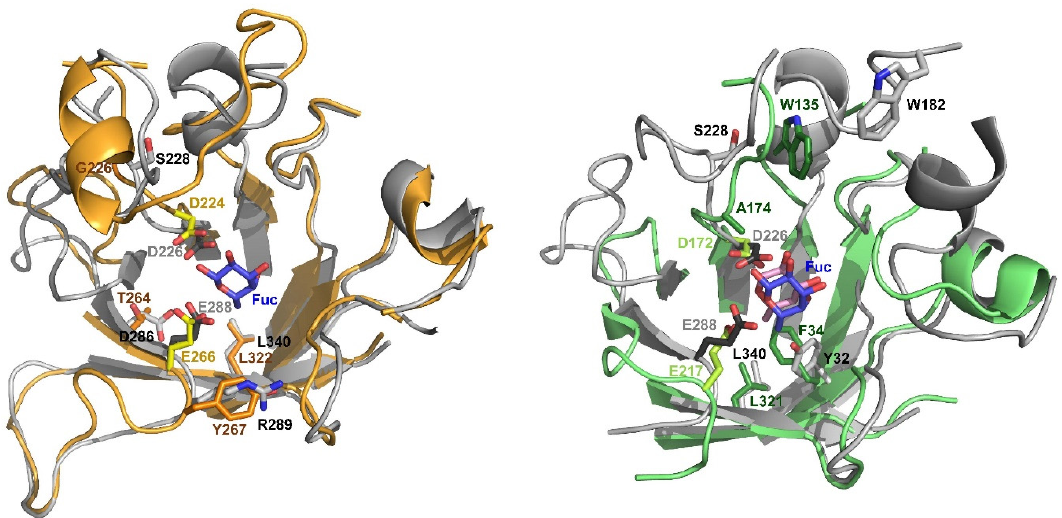
Figure 1. Active site structural alignments of Fg FCO1 (grey; PDB 4NI3) with Tm α Fuc (orange; model on PDBs 1HL9 and 2ZWY) and Bi AfcB (green; PDB 3UES) indicating catalytic residues (dark grey with grey labels in Fg FCO1, yellow in Tm α Fuc, and lime green in Bi AfcB). Residues that upon mutation had the most beneficial effect on transglycosylation in Tm α Fuc [13] and Bi AfcB [6,34] are indicated in orange ( Tm α Fuc; brown labels) or green ( Bi AfcB; green labels) alongside the corresponding residues if Fg FCO1 (grey with black labels). Corresponding Fg FCO1 residues were determined from multiple sequence alignment (Figure S1) guided by structural alignment around the catalytic acid/base (E288 in Fg FCO1), where sequence alignment is generally poor in GH29 [36]. Fuc ligands from Fg FCO1 (blue; PDB 4PSR) and Bi AfcB (pink; PDB 3UET) are indicated. Residues more than 14 Å away from the ligand are hidden for simplicity (with a few manual modifications). In the alignment of Fg FCO1 and Tm α Fuc (left) amino acids 45-76 ( Tm α Fuc) and 46-52 ( Fg FCO1) are also hidden as they block the view of the active site. The opening of the active site is facing the reader.